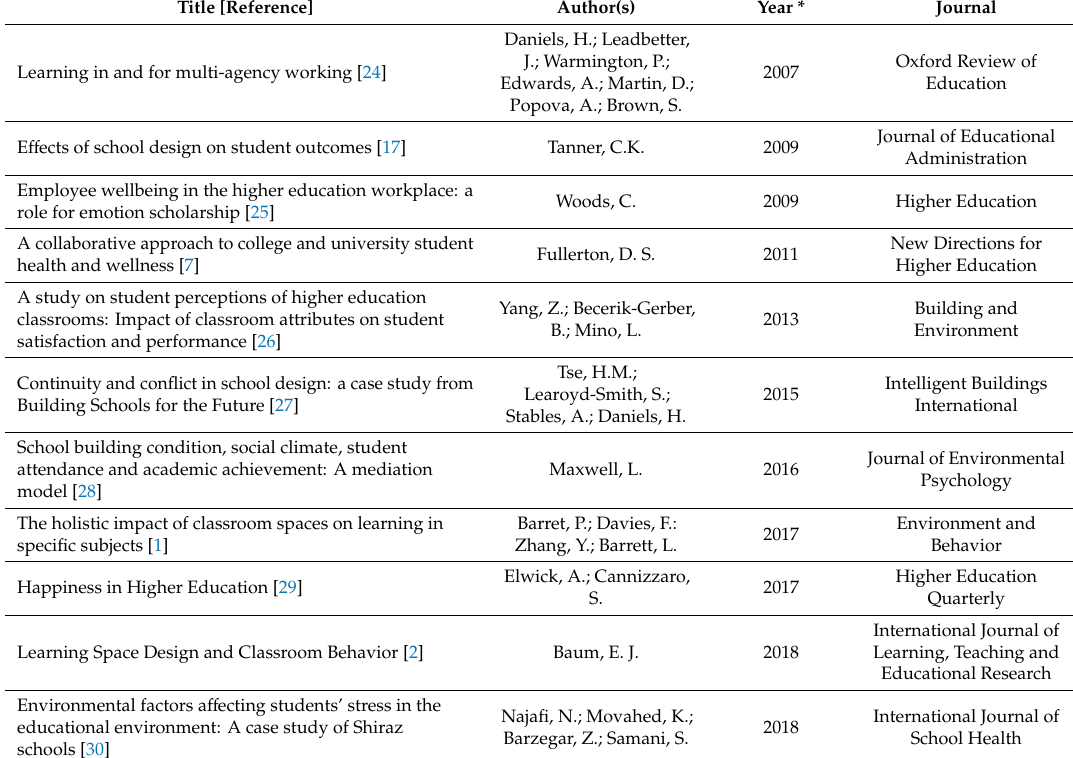
Table 1. Main publications reviewed of the object of